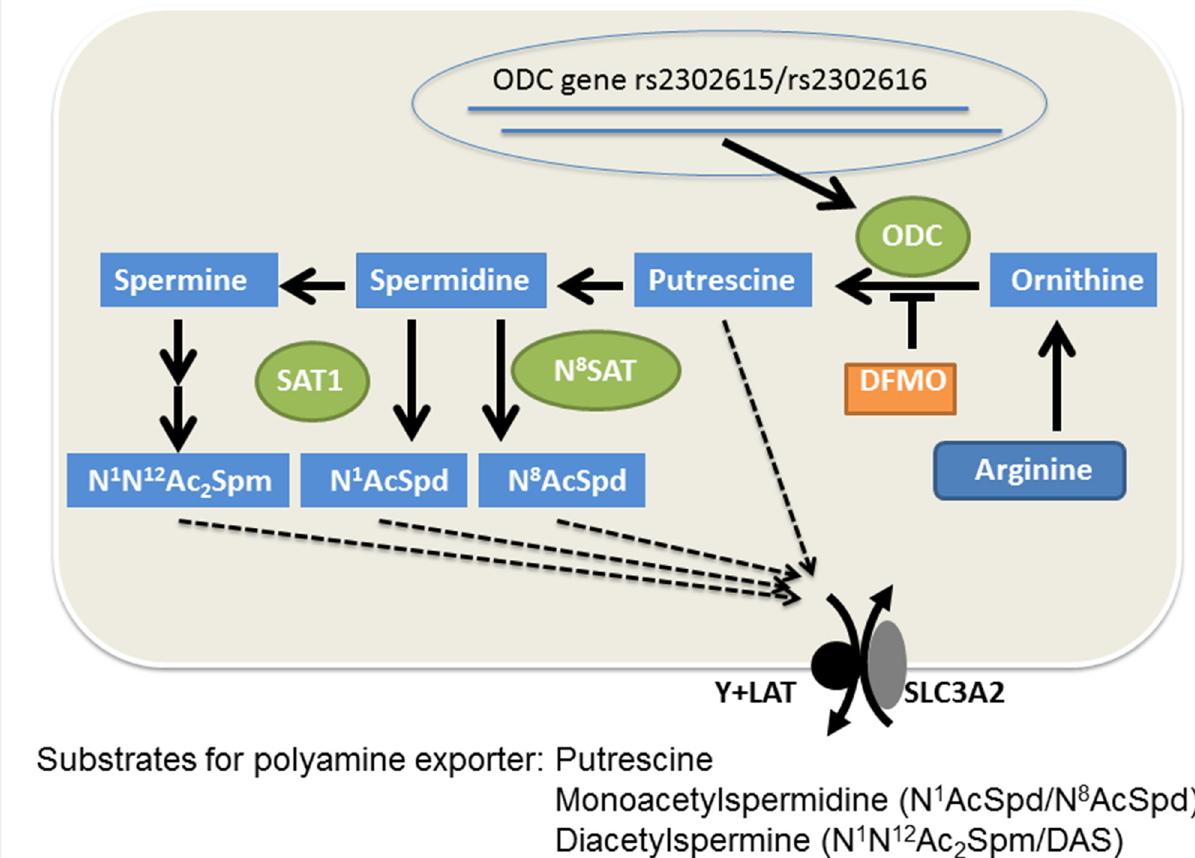
Fig 4. Rationale for DFMO- and specific genetic and metabolic markers of DFMO effect, in neuroblastoma . ODC transcription is influenced by specific genetic variability, including the SNPs rs2302615 [19, 22] and rs2302616 [24]. The DFMO target ODC decarboxylates ornithine to form the diamine putrescine, which is then metabolized into longer chain amines. Spermidine is a substrate for two acetyltransferases that monoacetylate this amine at either the N 1 or N 8 positions. Spermine is a substrate for one of these transferases (SAT1), which diacetylates this amine. Putrescine, the monoacetylspermidines and diacetylspermine are all substrates for the solute carrier transporter SLC3A2/Y+LAT, which exports these